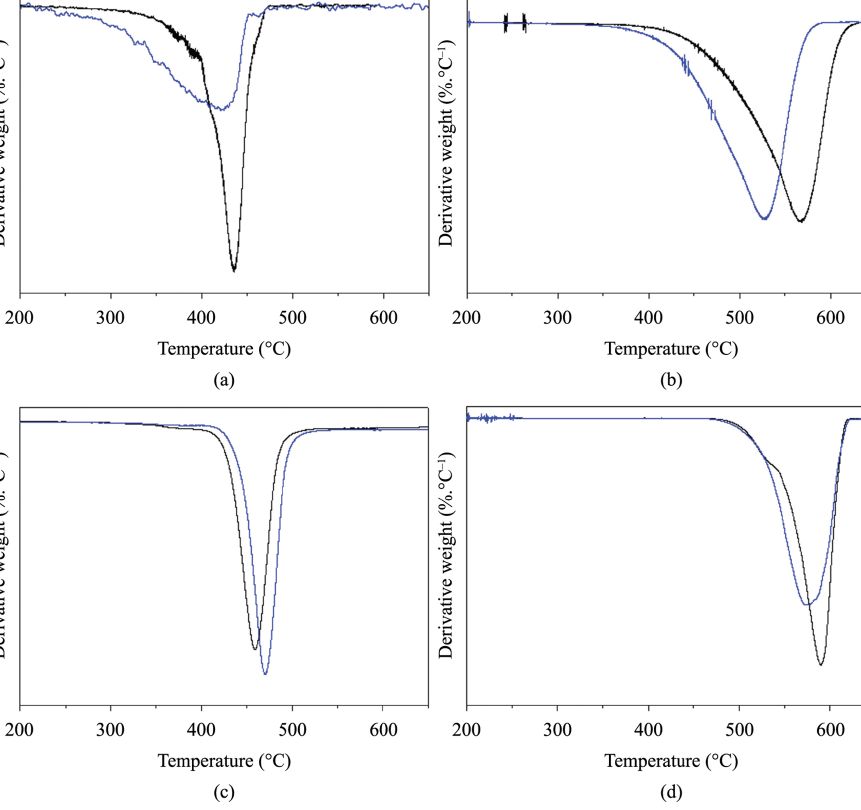
Figure 4. DTG analysis of (a) PP; (b) PDMS; (c) PVDF and (d) PTFE. Black line is relative to sample without contact with ozone and blue line to the sample after 4h of